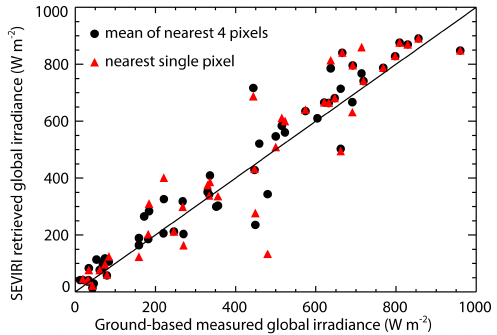
Figure 8. Scatter plot of SEVIRI retrieved global irradiance at the surface (surface solar irradiance, Figure 8. Scatter plot of SEVIRI-retrieved global irradiance at the SSI) vs. ground-based measured global irradiance at 11:30UTC at De Bilt on all 63 actinic flux surface (surface solar irradiance, SSI) vs. ground-based measured profile measurement days. The black line is the one-to-one line. The black dots indicate the mean global irradiance at 11:30UTC at De Bilt on all 63 actinic flux 0 . 1 ◦ (latitude SSI of all SEVIRI pixels in a 0 . 1 ◦ longitude) grid box. The red triangles indicates profile measurement days. The black line is the one-to-one line. Figure 9. Cloudy sky case on 5 September 2006. (a) SEVIRI cloud optical thickness image at × × Figure 9. Cloudy-sky case on 5 September 2006. (a) SEVIRI cloud the nearest single pixel SSI in the grid box. 11:30UTC (balloon launch) and (b) at 13:00UTC (balloon maximum height). The flight track of The black dots indicate the mean SSI of all SEVIRI pixels in optical thickness image at 11:30UTC (balloon launch) and (b) at balloon is indicated as a white line. The location of balloon at the time the SEVIRI image is taken a 0.1 ◦ × 0.1 ◦ (latitude × longitude) grid box. The red triangles in- 13:00UTC (balloon maximum height). The flight track of balloon 0 . 1 ◦ is indicated as a white circle. (c) SEVIRI single pixel cloud optical thickness values in 0 . 1 ◦ × dicates the nearest single-pixel SSI in the grid box. (latitude longitude) boxes along the trajectory of the balloon (dots) as a function of the height of is indicated as a white line. The location of balloon at the time × the balloon. The COT values used in the simulations are connected by the black line. (d) Measured the SEVIRI image is taken is indicated as a white circle. (c) SE- actinic flux profile and simulated actinic flux profile (both normalized at 30 km altitude, respectively). VIRI single-pixel cloud optical thickness values in 0.1 ◦ × 0.1 ◦ (lat- The actinic flux profile is also shown zoomed-in at 0–10 km . itude × longitude) boxes along the trajectory of the balloon (dots) as a function of the height of the balloon. The COT values used in the 36 simulations are connected by the black line. (d) Measured actinic 35 flux profile and simulated actinic flux profile (both normalized at 30km altitude, respectively). The actinic flux profile is also shown zoomed in at